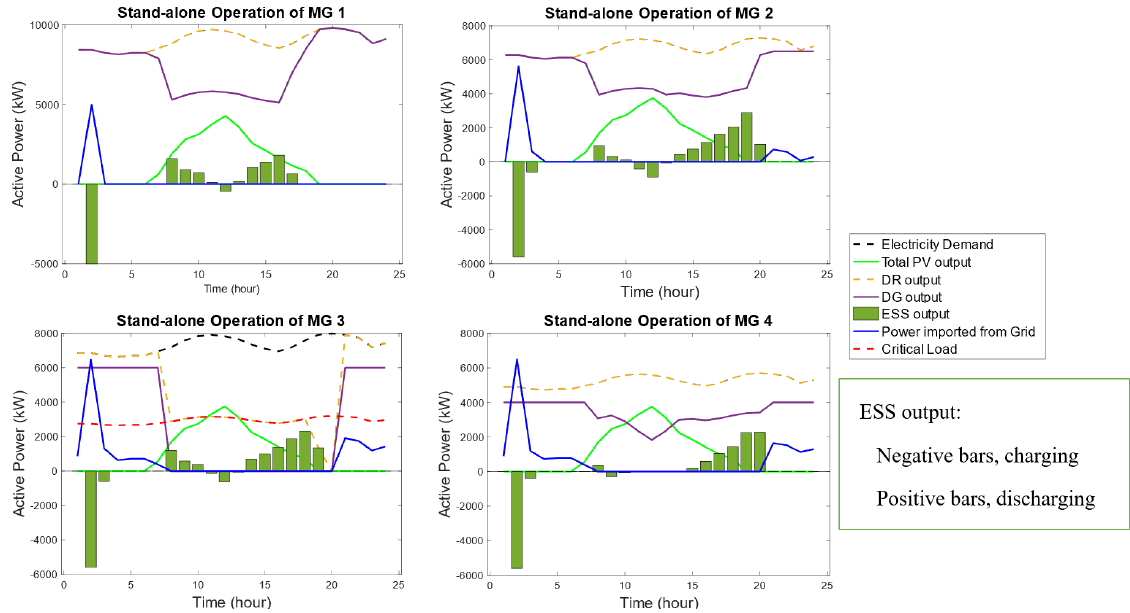
Figure 7. Interconnected MGs in off-grid mode and without power sharing.